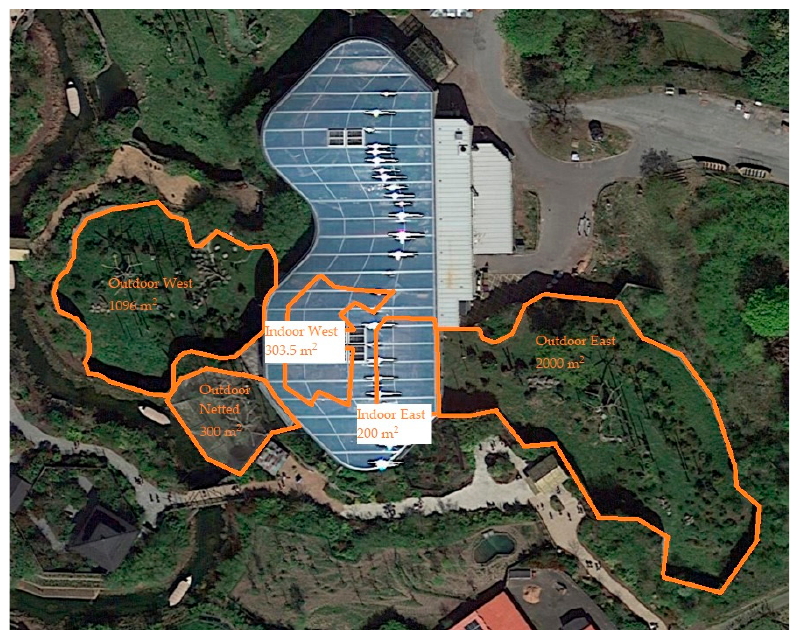
Figure A2. Enclosure plan for Sumatran orangutan ( Pongo abelii ) in Monsoon Forest , within the Islands expansion. Orange lines signify approximate areas accessed by individual animals with dimensions of total available space. During data collection periods, individuals only had access to Outdoor West, Indoor West and Outdoor Netted areas. Copyright: Google Earth.